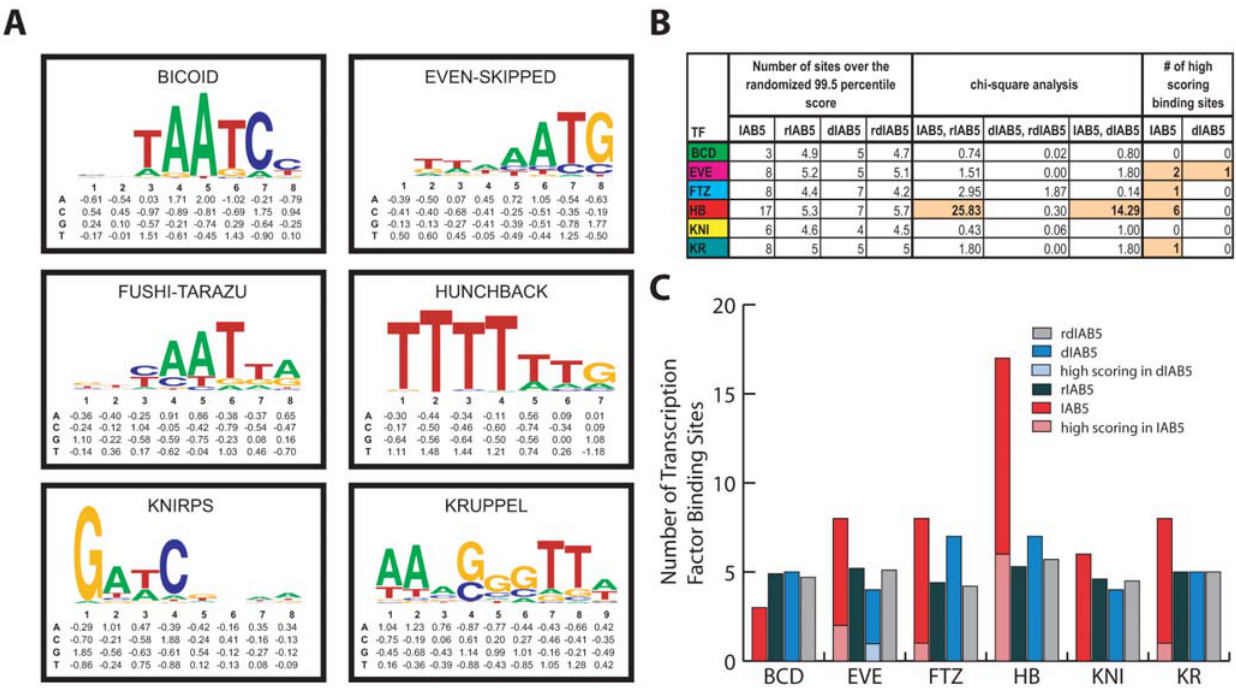
Figure 4. Bioinformatic identification of high-scoring TFBSs in the IAB5 enhancer CRM. (A) TFBS consensus sequences and Position Weight Matrices. TF consensus bindingsite sequencesforBICOID (BCD), EVEN-SKIPPED(EVE), FUSHI-TARAZU (FTZ), HUNCHBACK(HB),KNIRPS(KNI) andKRUPPEL (KR) are shown above the PWM generated from experimentally-verified TF binding sites compiled using databases from the Eisen [39], Siggia [40] and Desplan [41] laboratories in combination with the Transfac public database [42] and additional literature searches (see Materials and Methods and Dataset S1). The height of each of the nucleotide bases reflects the relative likelihood of their presence at that position in the TFBS. (B) Identification of high-scoring TFBSs in IAB5. Rows show each of the TFs; BCD, EVE, FTZ, HB, KNI, and KR. Columns show the number of TFBSs found in IAB5, randomized IAB5 sequence (rIAB5), downstream IAB5 (dIAB5), and randomized downstream IAB5 sequence (rdIAB5) over the 99.5 percentile score (see Materials and Methods for a detailed description of how the 99.5 percentile was calculated); chi-square values obtained when comparing the number of TFBSs above the 99.5 percentile from IAB5 to rIAB5, dIAB5 to rdIAB5, and IAB5 to dIAB5; and the number of high-scoring binding sites found in the IAB5 and dIAB5 sequence (see Materials and Methods for a detailed description of high-scoring binding site). Values highlighted in orange refer to statistically significant values (p , 0.05). (C) Quantitative comparison of predicted TFBSs in IAB5. Graphical representation of the number of TFBSs found in IAB5 (red), rIAB5 (black), dIAB5 (blue), and rdIAB5 (gray) for each of the transcription factors BCD, EVE, FTZ, HB, KNI and KR. The number of high-scoring TFBSs found in IAB5 (light red) and in dIAB5 (light blue) are also indicated. The general trend revealed by this analysis is that the IAB5 CRM is enriched in putative TFBSs for all the TFs analyzed (except BICOID, which is not thought to directly bind IAB5) when compared to the downstream and randomized